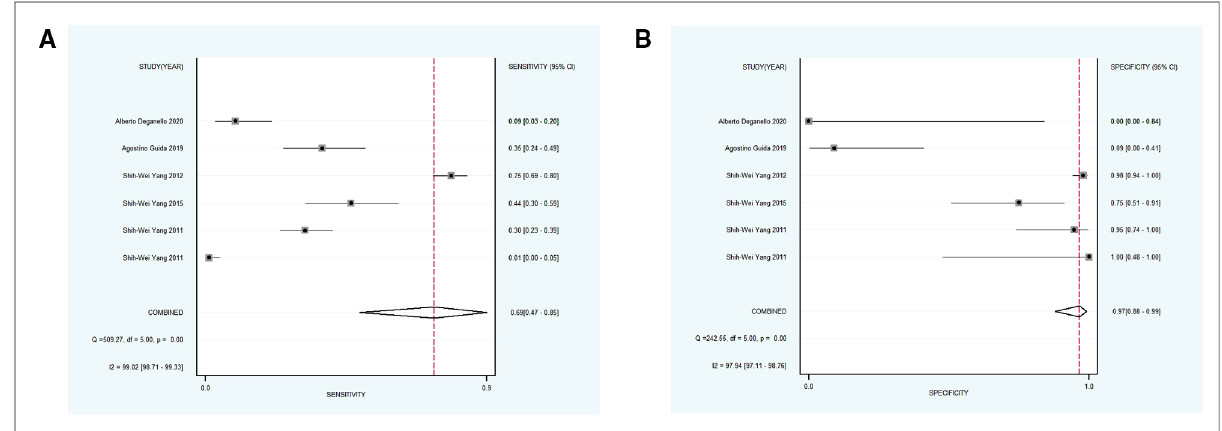
FIGURE 6 ( A,B ) forest plot of sensitivity and speci fi city of subgroup 3 pertaining the diagnostic accuracy of NBI for the malignant transformation of